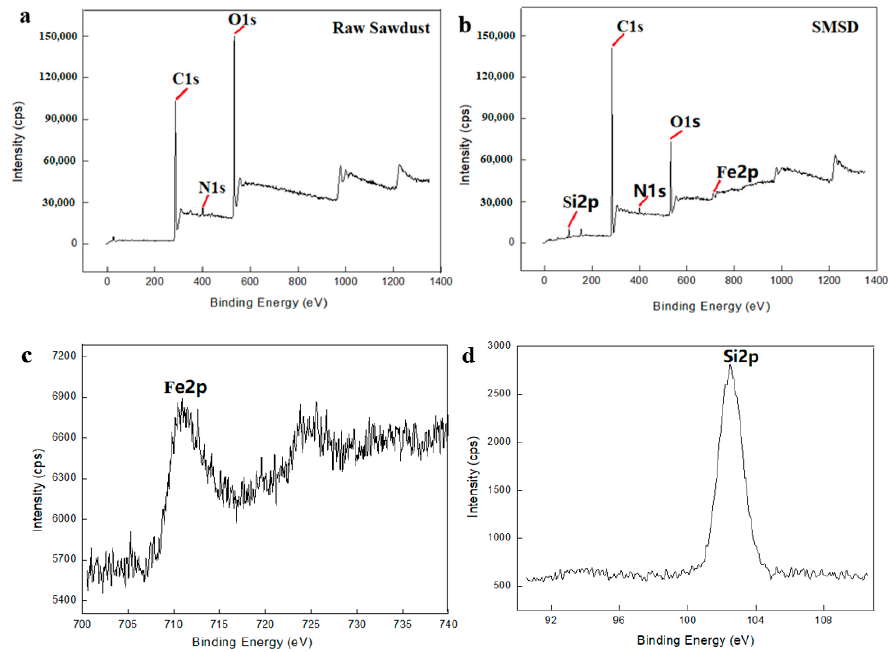
Figure 4. X-ray photoelectron spectroscopy (XPS) survey spectra of raw sawdust ( a ), SMSD ( b ); the high-resolution XPS spectra of Fe 2p ( c ) peaks and Si 2p ( d ).